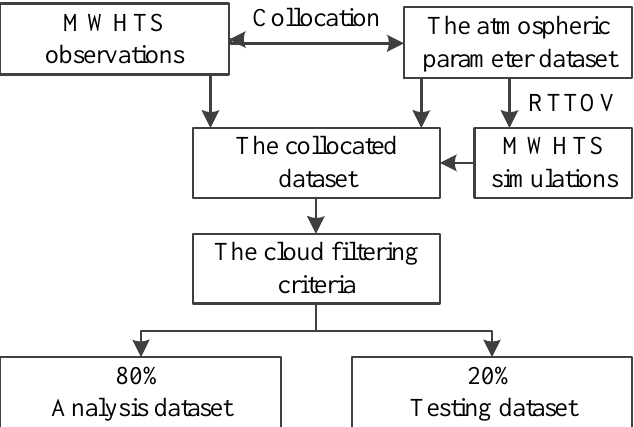
Figure 1. The schematic of the data-preprocessing procedure.